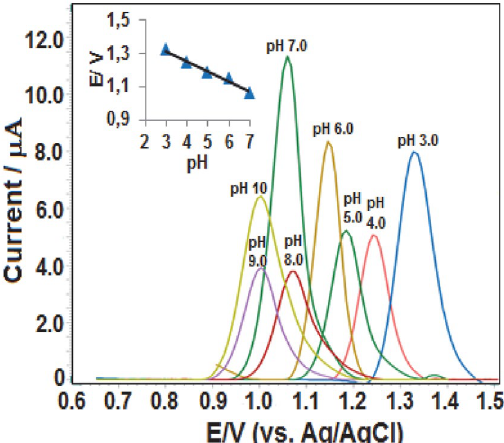
zole in BR buffer, pH 3 –10 . Electrode, PGE. AdSV conditions: accu- mulation time 30 s at open-circuit condition. SWV parameters: frequency, 50 Hz; step potential, 8 mV; pulse amplitude, 30 mV. In- set depicts the plot of Ep vs.